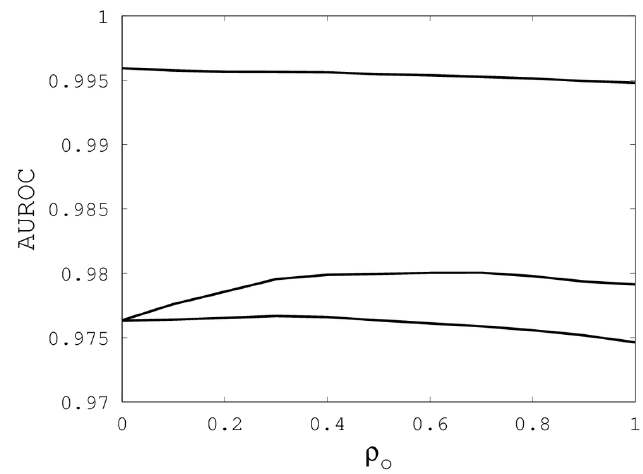
Figure 2. The best AUROC over all ( κ, ρ with one of the random sub-groups of the Proteus300